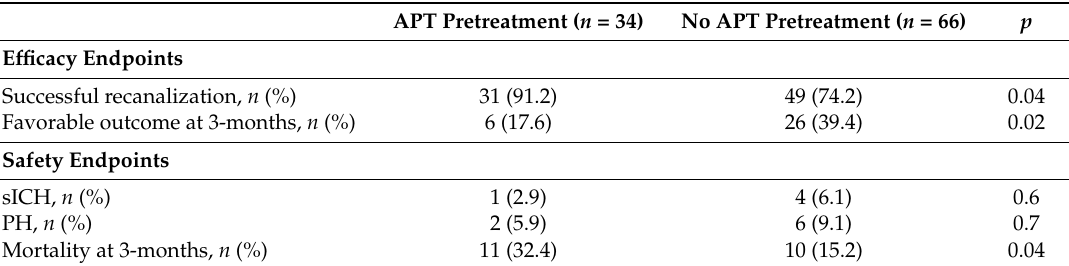
Table 3. Efficacy and safety endpoints.